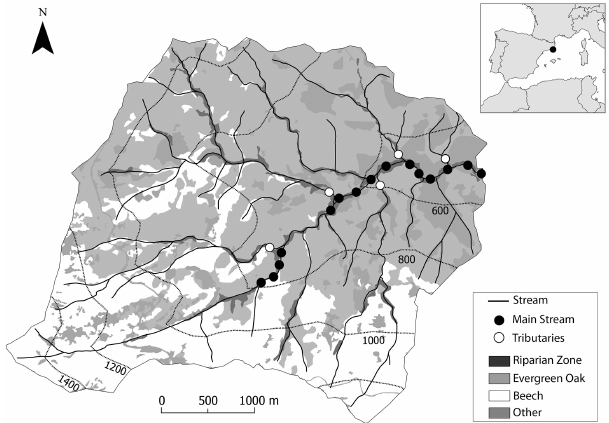
Figure 1. Map of the Font del Regàs catchment within the Montseny Natural Park (NE, Spain). The vegetation cover and the main stream sampling stations along the 3.7km reach are indicated. There were 5 and 10 sampling stations along the second- and third- order sections, respectively. Four permanent tributaries discharged to the main stream from the upstream- to the downstream-most site (white circles). Additional water samples were collected from a small tributary draining through the inhabited area at the lowest part of the reach. The remaining tributaries were dry during the study period.